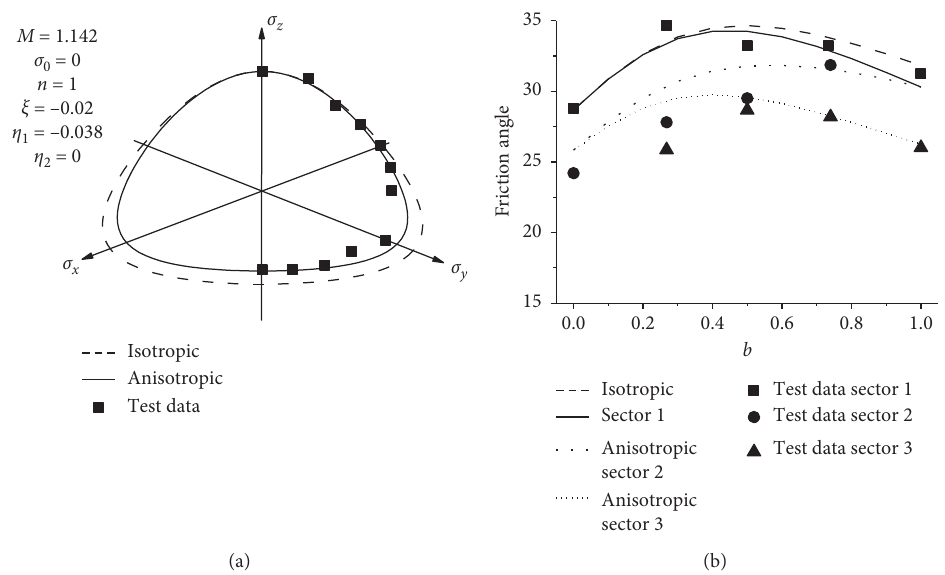
Figure 7: Verifications of the two criteria for glass beads in (a) the octahedral plane; (b) the b – φ diagram (test data from [35]; this figure is reproduced from